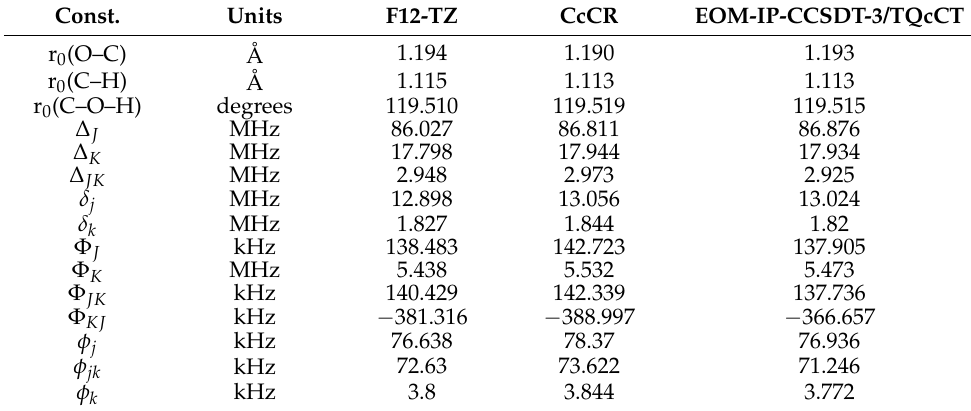
Table A6. ˜X 2 B 1 H 2 CO + Distortion Constants and Geometrical Parameters.